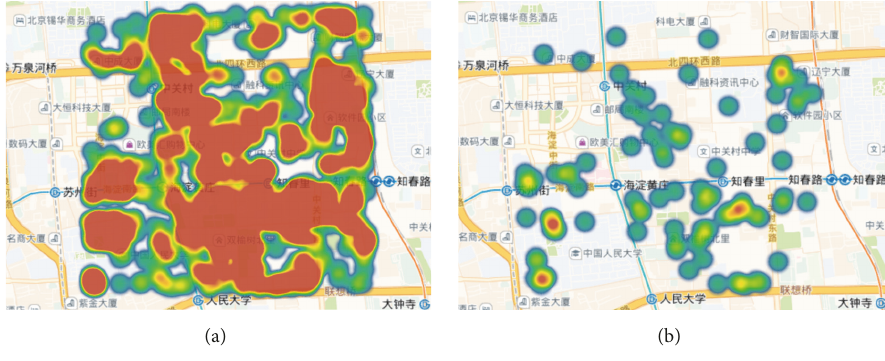
Figure 4: Heat map of bike-sharing.